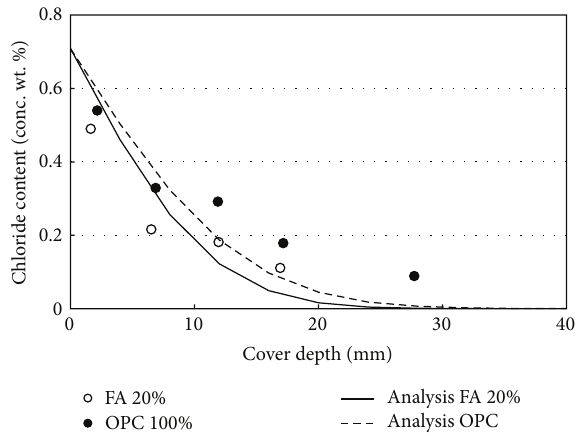
Figure 11: Chloride profile between results from test and this study.